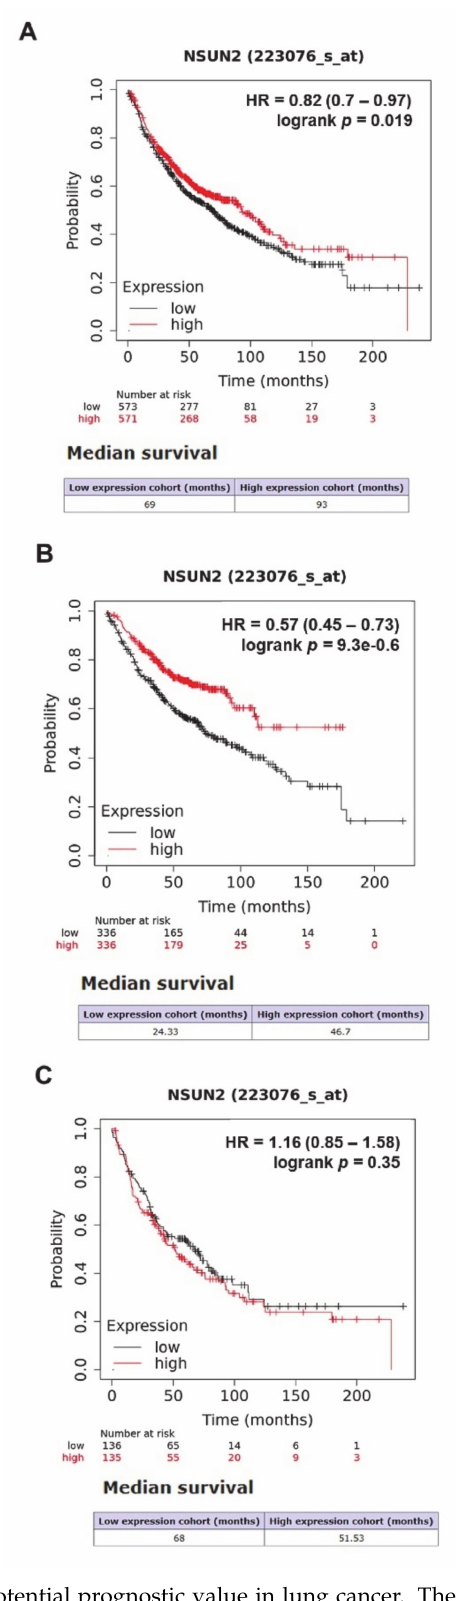
Figure 6. NSUN2 has a potential prognostic value in lung cancer. The potential prognostic value of NSUN2 mRNA expression was evaluated using KM-Plot [115]. Patients were split using median expression, and survival was assessed using the default parameters. Analyses were conducted based on ( A ) all histologies, ( B ) LUAD, and ( C )